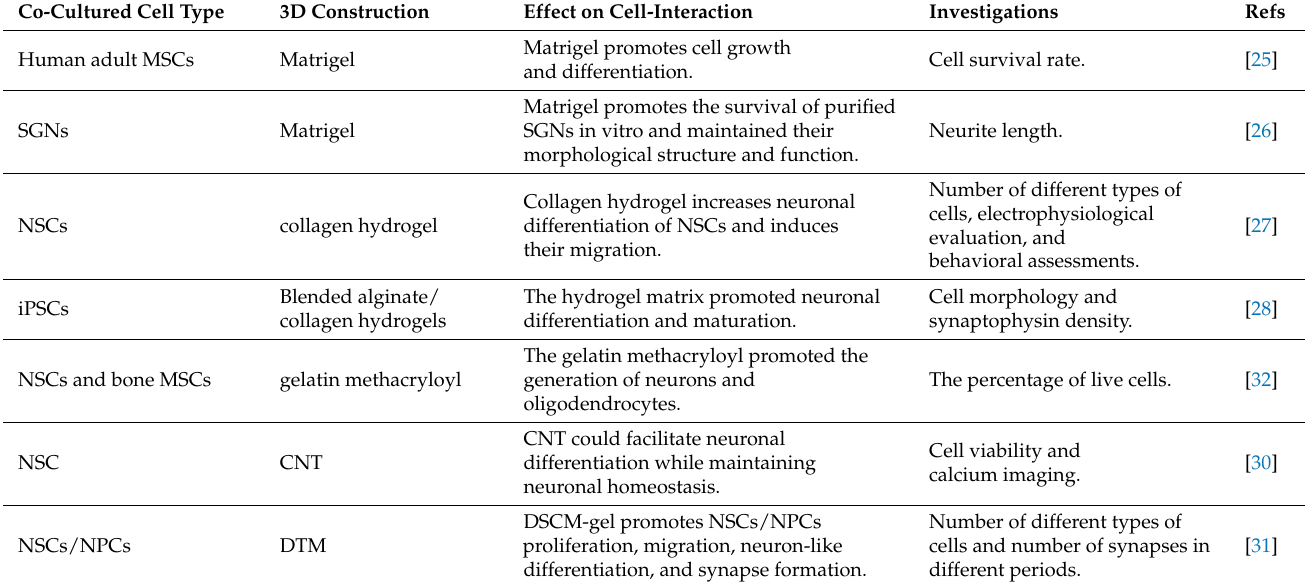
Table 1. Cell-based 3D co-culture